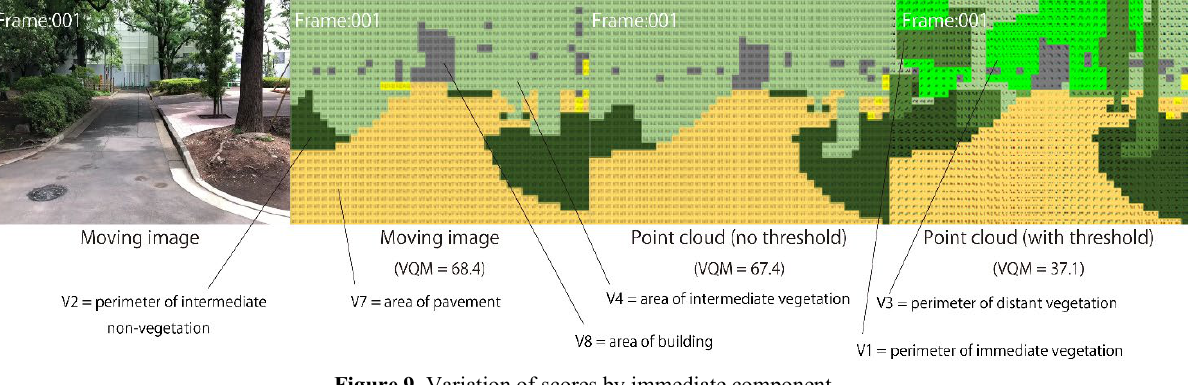
Figure 9 . Variation of scores by immediate